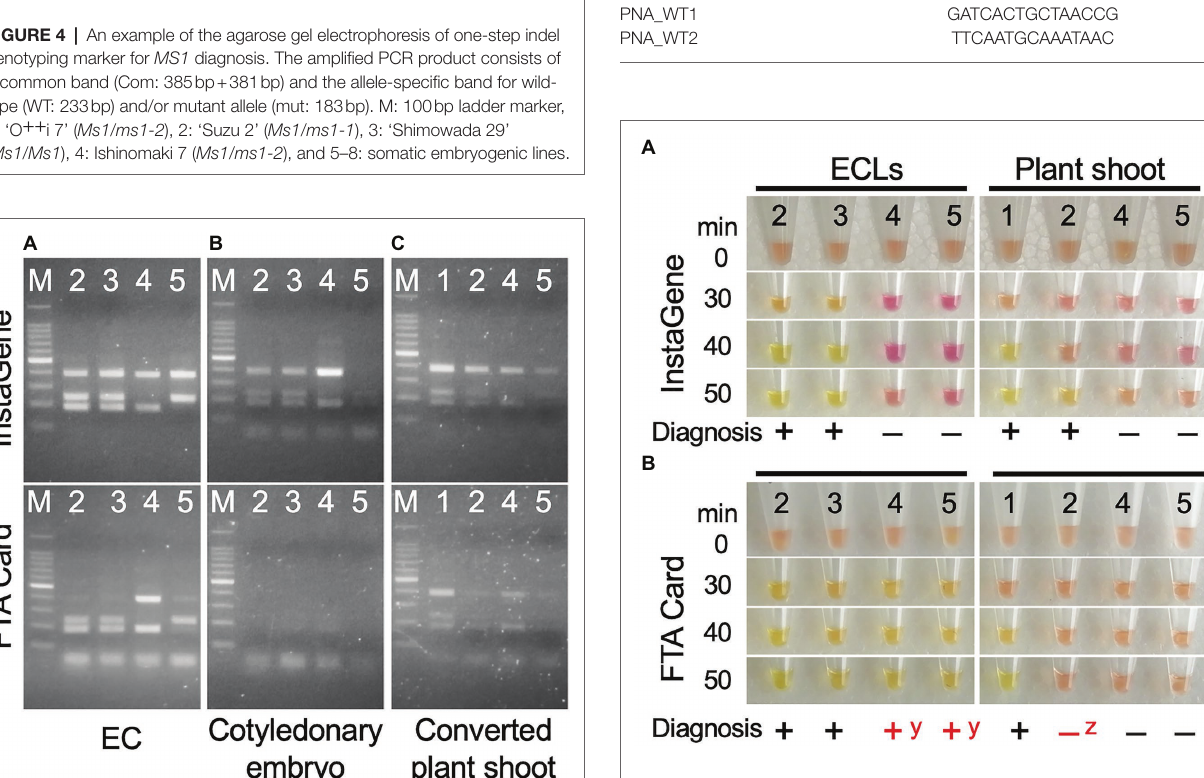
FIGURE 6 | LAMP diagnosis of the presence of mutant allele ms1-2 on the ECs and shoot tip of the developed plants using DNA template extracted by InstaGene (A) and FTA Card (B) . 1–3: ms1-2 -positive samples (1: FO7-97, 2: FO7-141, 3: FO7-144), 4, 5: negative (without ms1-2 ) samples (4, SSD-18, 5: T4-11-51). y false positive, z false